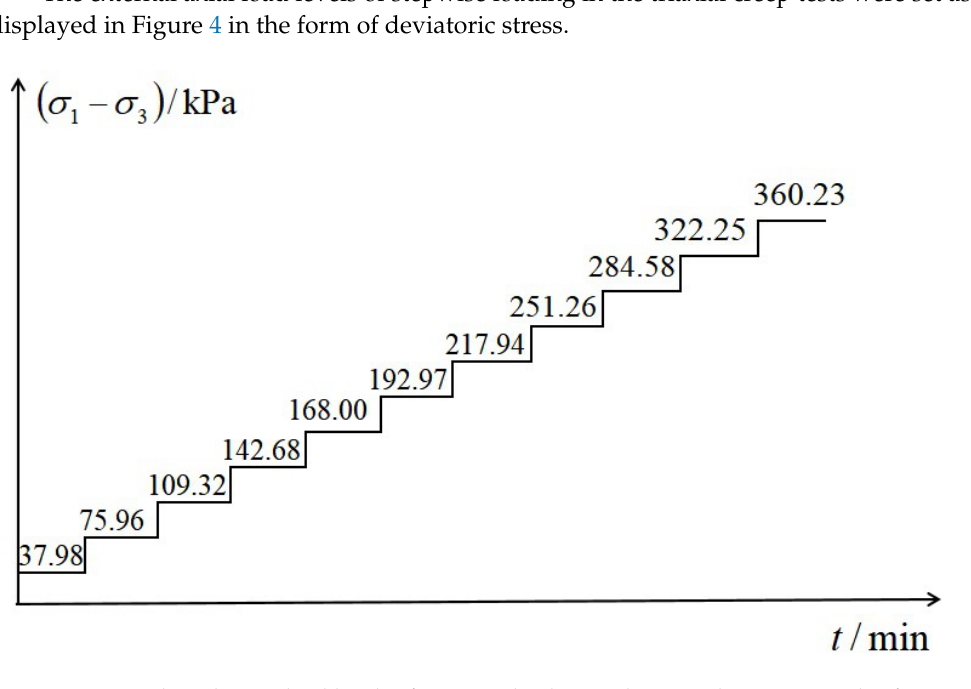
Figure 4. External axial stress load levels of stepwise loading in the triaxial creep tests. This figure is mainly to display the stress levels. The time duration of each stress level is generally not equal, but decided based on the deformation to be stable.